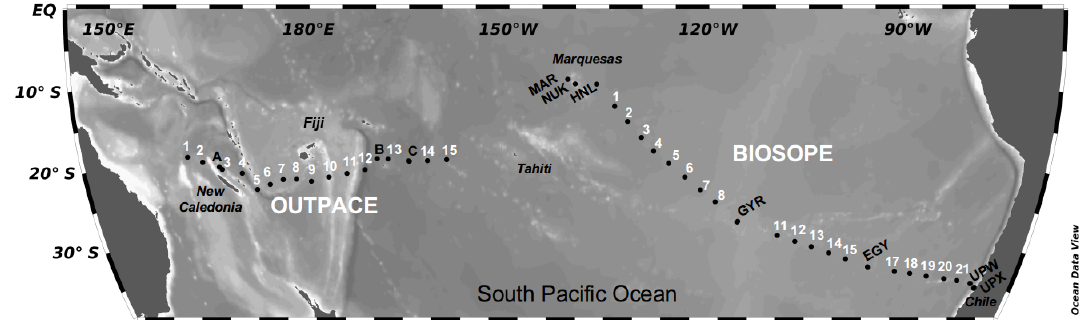
Figure 1. Bathymetric map of the stations sampled in the South Pacific Ocean during the OUTPACE cruise (February–April 2015) and the BIOSOPE cruise (October–November 2004). Short-duration stations are indicated in white, and long-duration stations (typically 2–3 days) in